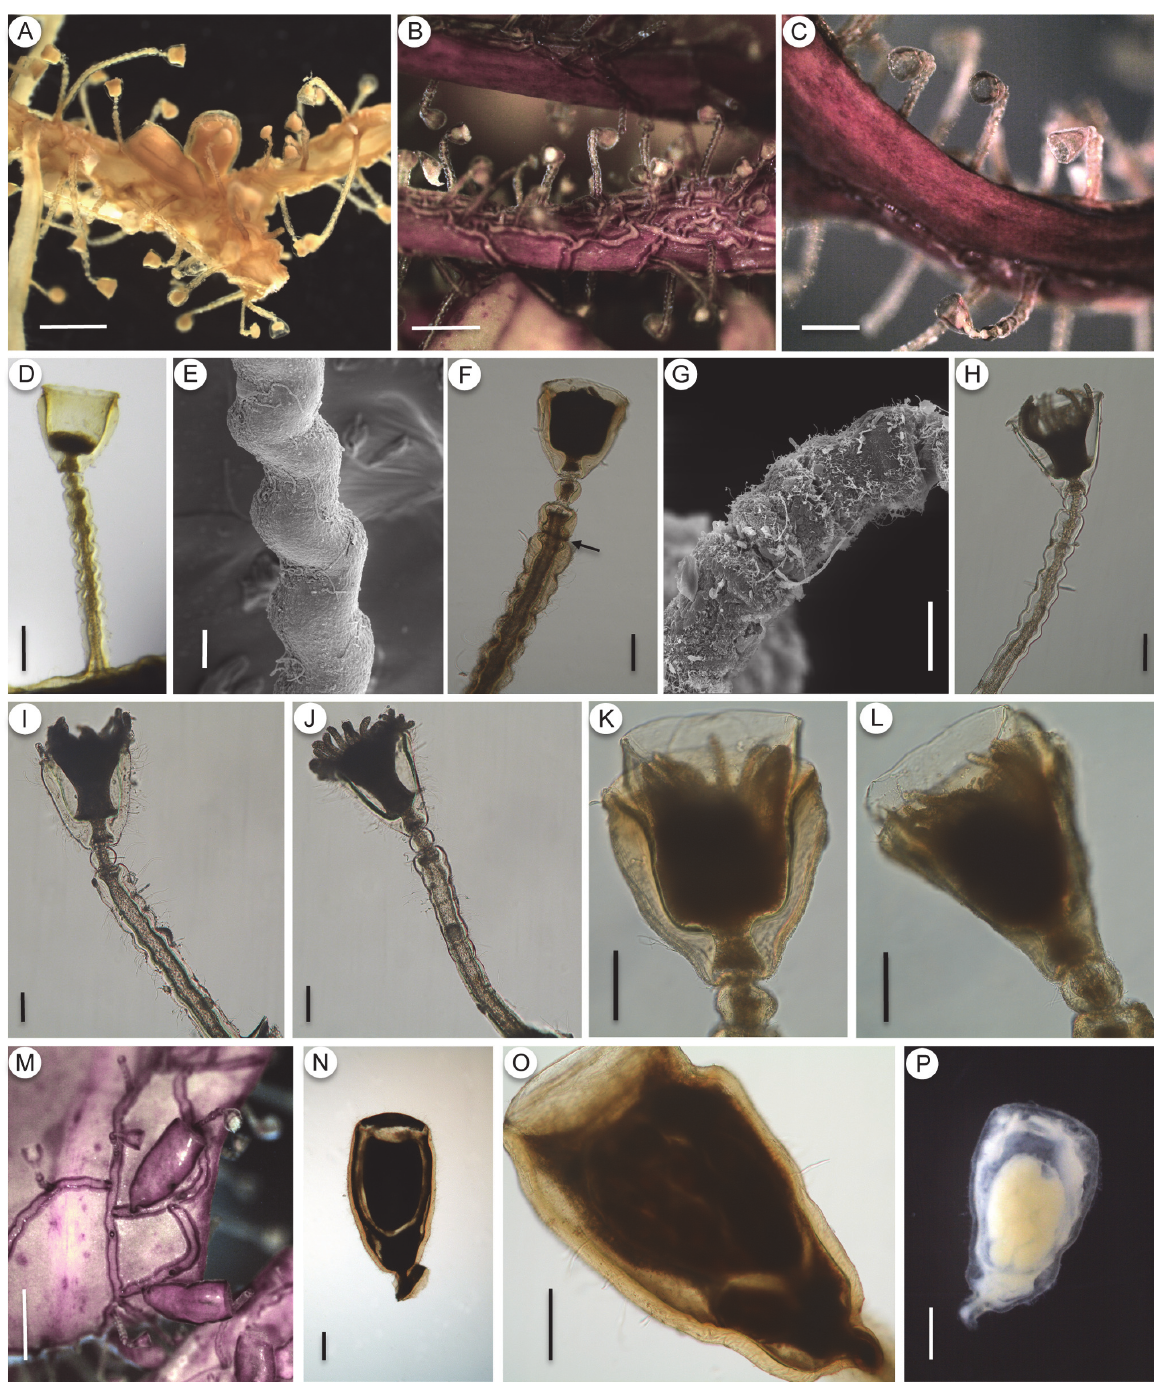
Fig 8. Orthopyxis caliculata . A-C: general view of the colony (A-MZUSP 4177; B,C- MZUSP 1563); D-H: detail of the trophosome with the sinuosities of the pedicel (E) and constrictions in the perisarc (arrow in F, G) (D-MZUSP 2550; E-MZUSP 2565; F-MZUSP 2554; G-MZUSP 4177; H-MZUSP 2552); I-J: positions of maximum (I) and minimum (J) perisarc thickness of the trophosome (MZUSP 2615); K-L: detail of the hydrotheca, showing two different forms due to compression (MZUSP 2554); M: general view of gonothecae on algae (MZUSP 2563); N: detail of male gonotheca (MZUSP 2554); O-P: detail of female gonothecae (O-MZUSP 2563; P-MZUSP 2613). Scales: A,B,M — 1 mm; C — 500 μ m; D,F,H,O — 200 μ m; E — 20 μ m; G — 50 μ m; I,J,K,L — 100 μ m; N, P — 300 μ